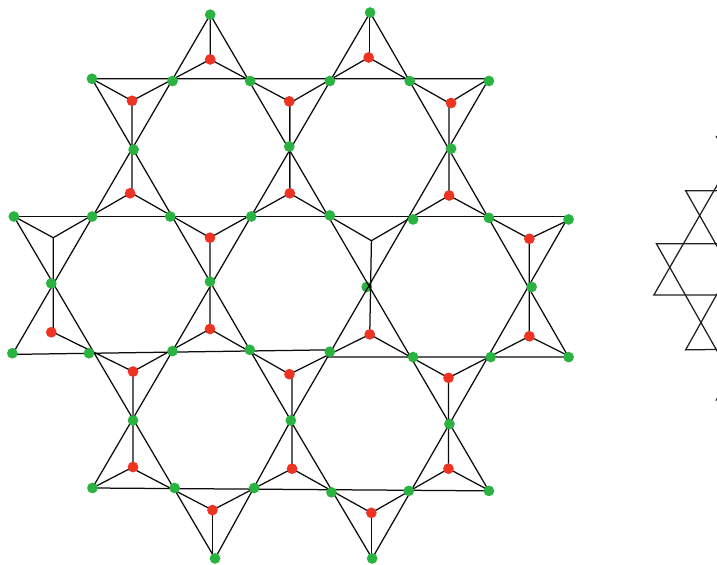
Figure 1: The silicate networks S